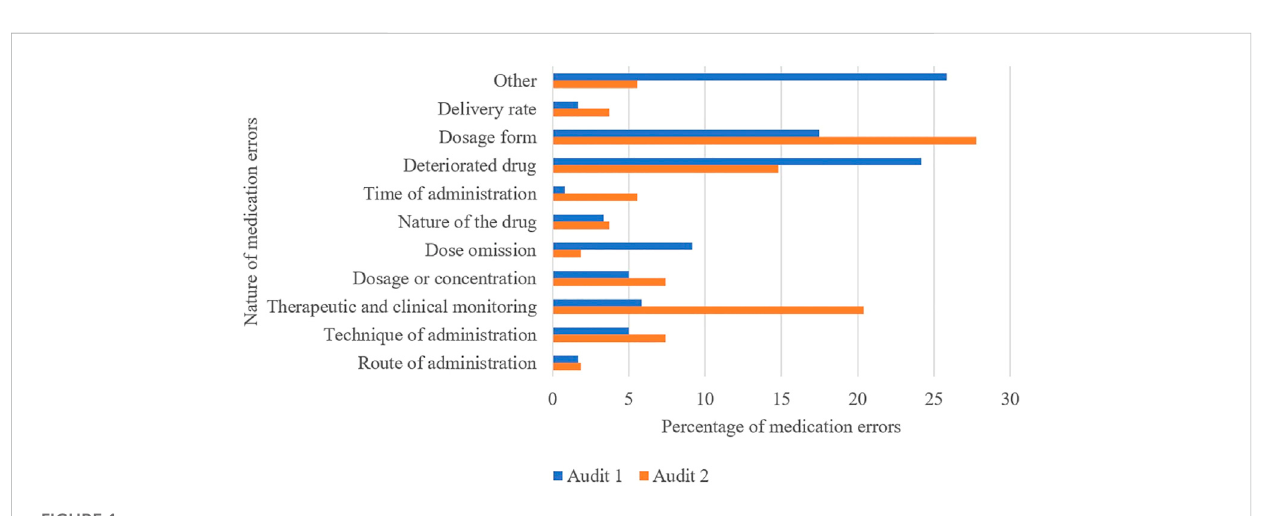
FIGURE 1 Distribution of medication errors by nature during both